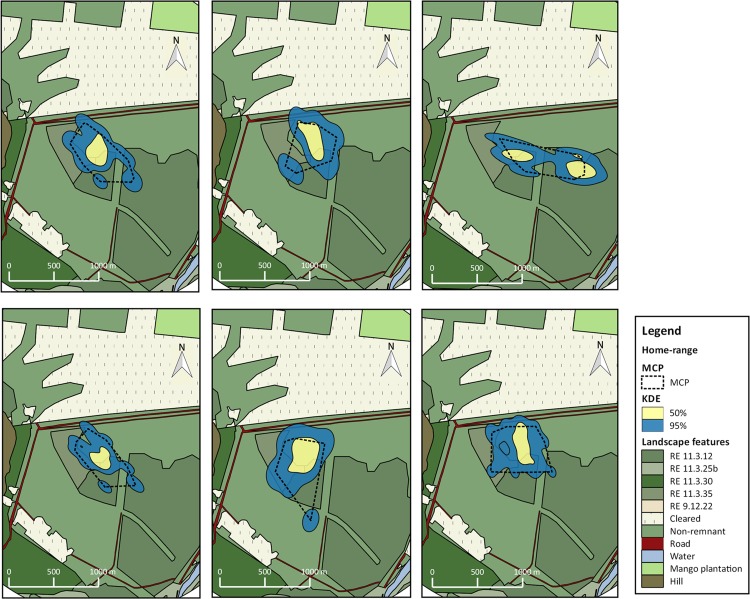
Home ranges for 6 individuals of BTF Poephila cincta cincta.Home ranges were calculated with 95%kde (blue fill), 50%kde (yellow fill) and MCP (dashed line) at Site 1, south Townsville. Regional ecosystems (dark green fills), mango plantations (light green fill), cleared areas (light yellow point pattern fill) and roads (dark red fill) are represented in the map.